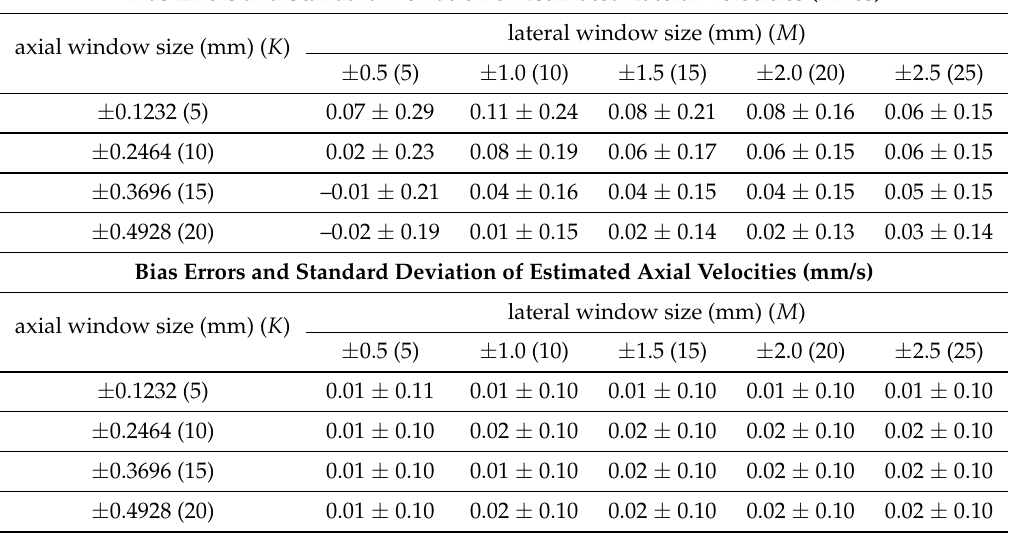
Table 10. Bias errors e bias and standard deviations σ of lateral and axial displacements at the same points shown in Figure 4a estimated by the proposed 2D motion estimator with frame averaging. Beamformed echo signals were obtained with rectangular apodization. Actual lateral and axial velocities were 1 mm/s and 0.5 mm/s,